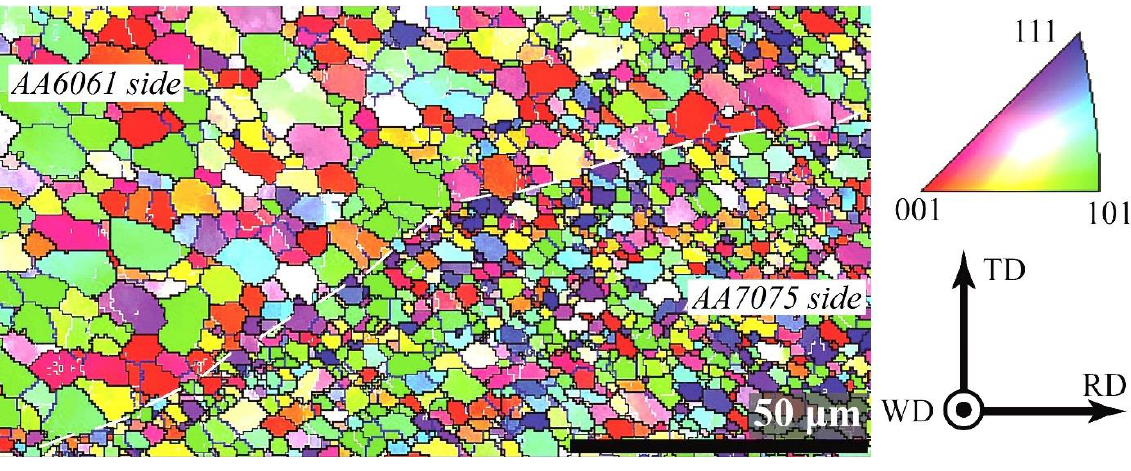
Figure 4. The IPF map of interfacial area in SZ indicated by the white rectangle 3 in Figure 2a. The interface between AA6061 and AA7075 alloys are drawn by a dashed line.